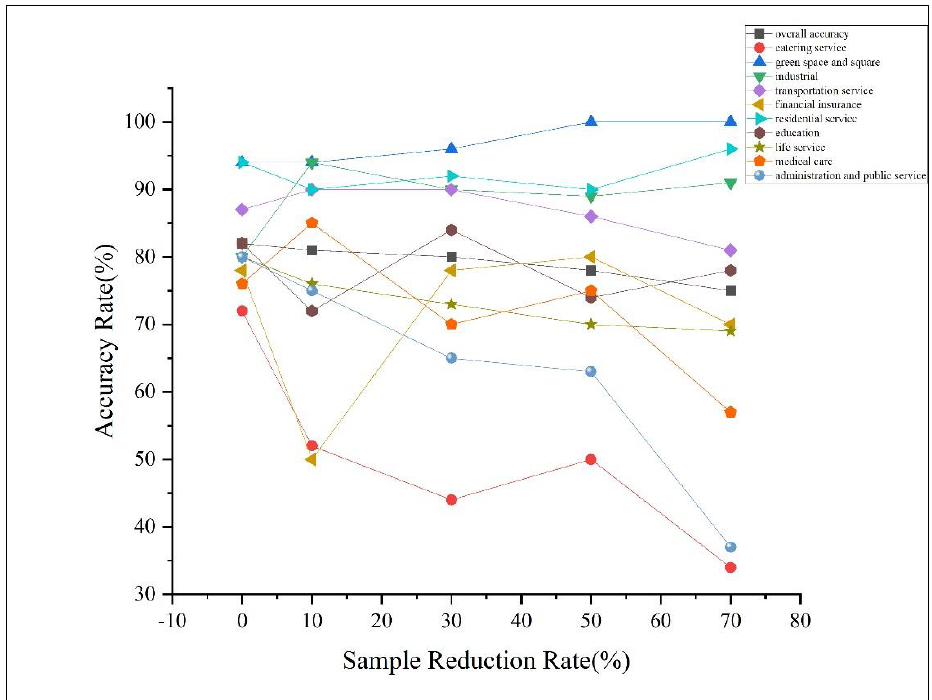
Figure 9. Sensitivity analysis of the sample reduction and accuracy rate.